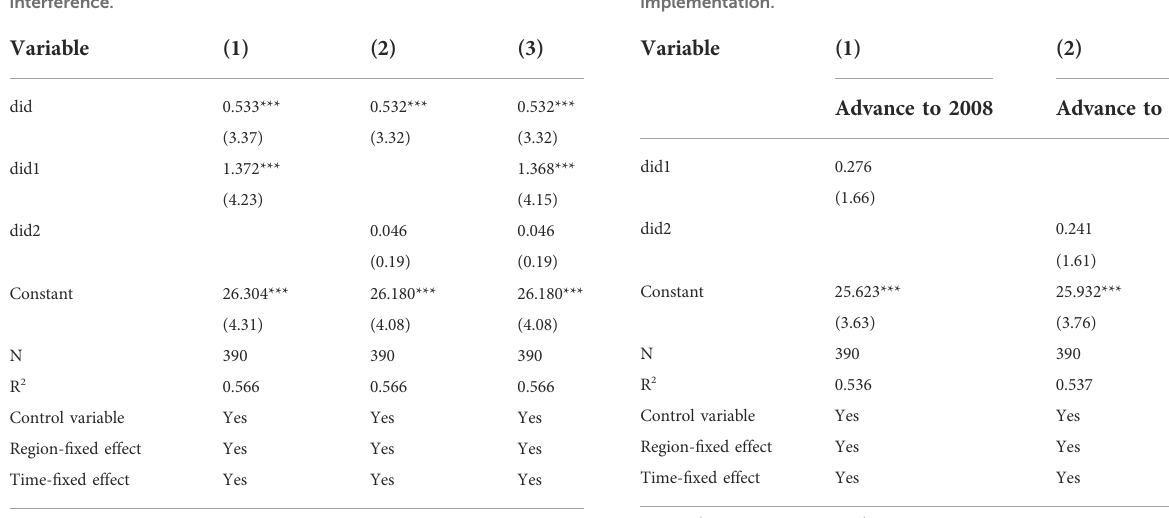
TABLE 4 Regression results of excluding other concurrent policies interference.